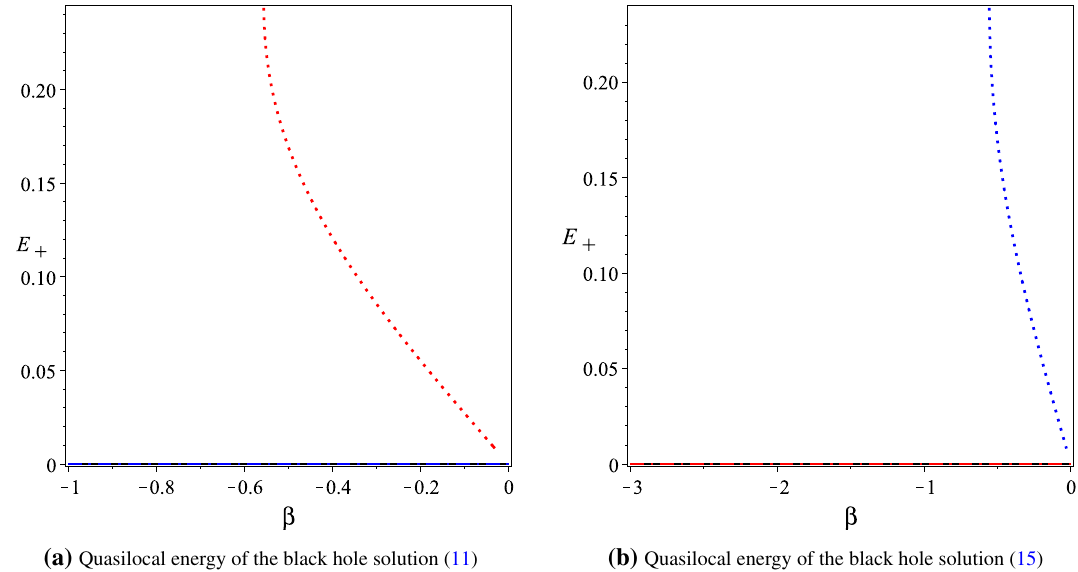
( a ) The entropy of the black hole solution in (b) The entropy of the AdS/dS black hole solution in the Einstein frame the Einstein frame Fig. 10 Schematic plot of the entropy of the two black holes in the Einstein frame versus the dimensional parameter α